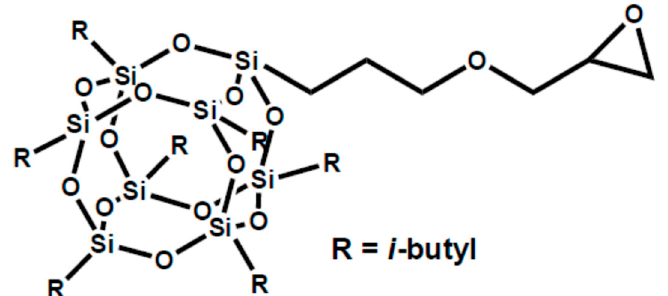
Figure 1. Chemical structure of glycidylisobutyl polyhedral oligomericsilsesquioxane